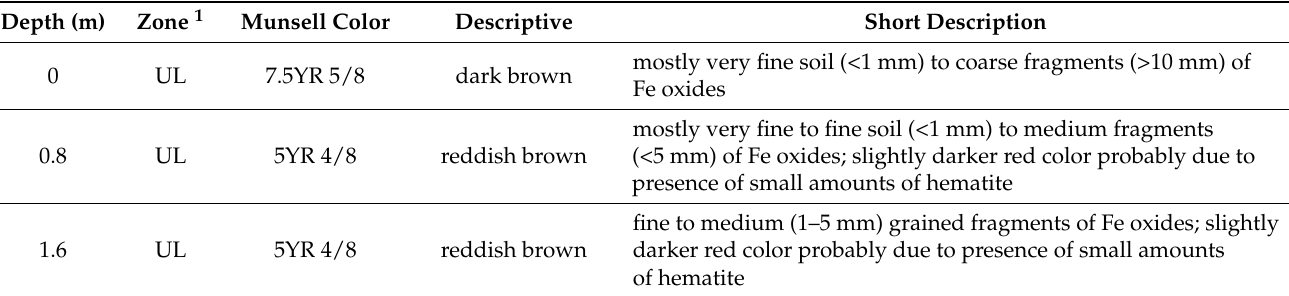
Table 1. Macroscopic description of samples from the limonite and transition